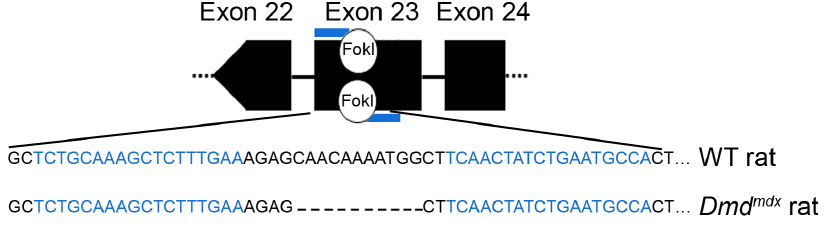
Figure 1. Targeted deletion in exon 23 of the rat Dmd gene via TALE nucleases. DNA cleavage takes place in the spacer sequence located between TALEN DNA binding sequences indicated in blue. Dmd mdx rats carries a deletion of 11 nucleotides in exon 23 of the Dmd gene.